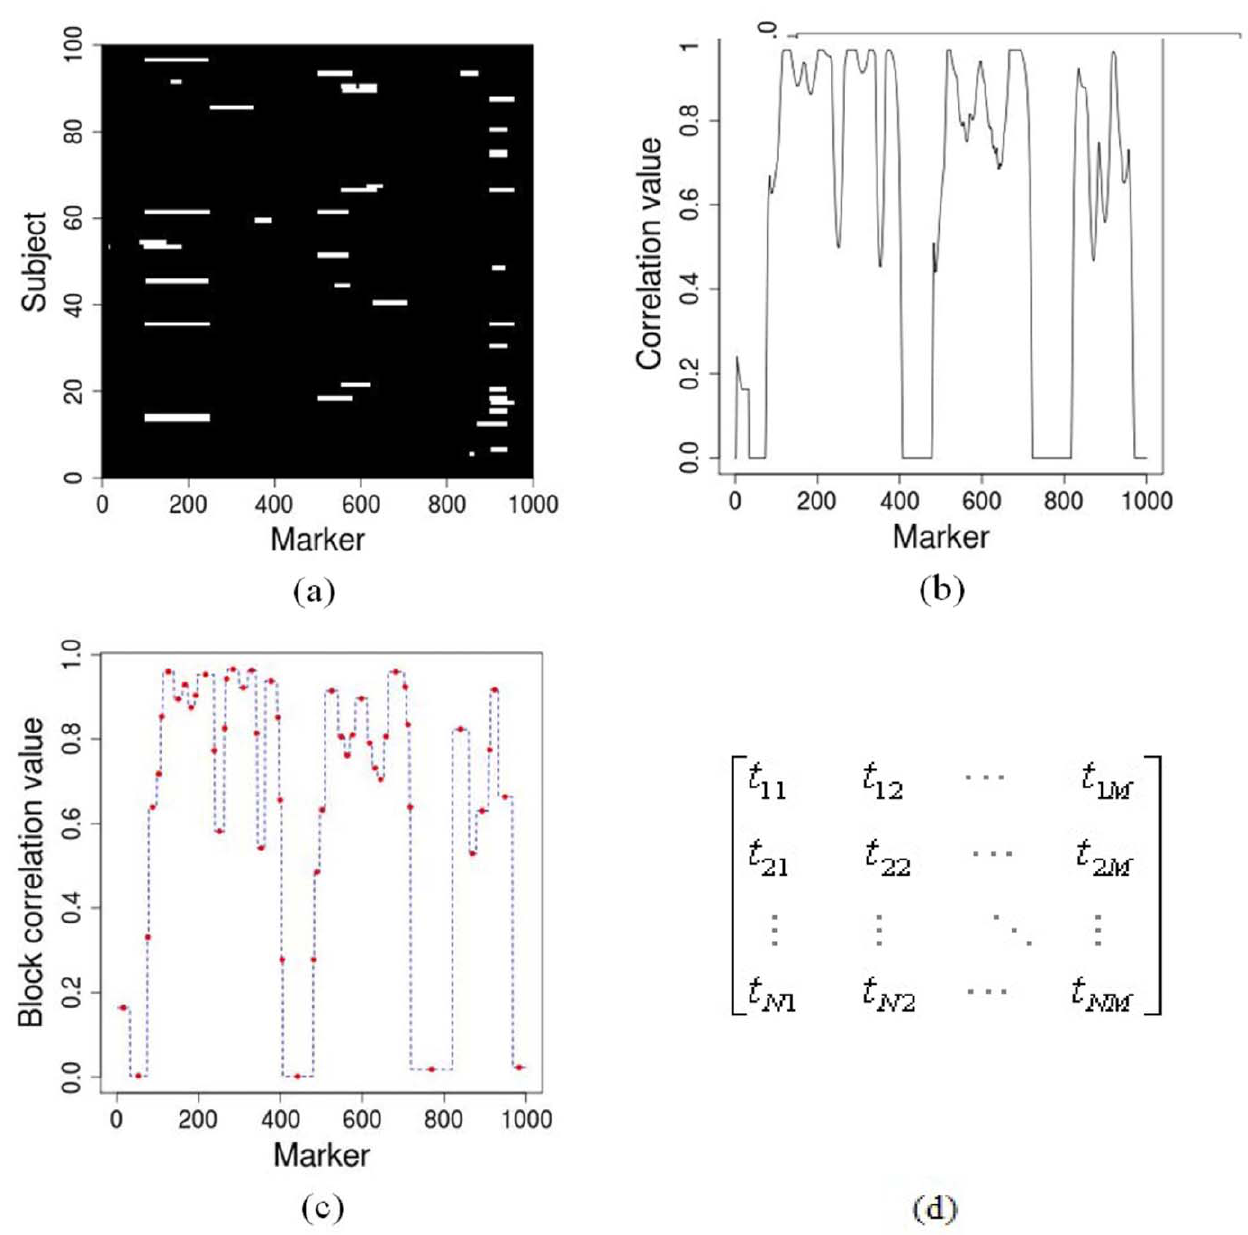
Figure 1. An example of tag marker selection procedure, (a) R (b) R (c) R (d). (a) A matrix profile of 100 subjects and 1000 markers; the white colored positions indicate copy number alterations. (b) The correlation value for each marker, which is the average coefficient among its surrounding markers. (c) Block correlation value resulted from the partition of the genome based on (b). (d) A new data matrix consisting of tag CNA markers (here N =100, M =50); each tag marker is selected from each block in (c), where the red dots are the middle of the blocks, representing tag markers.